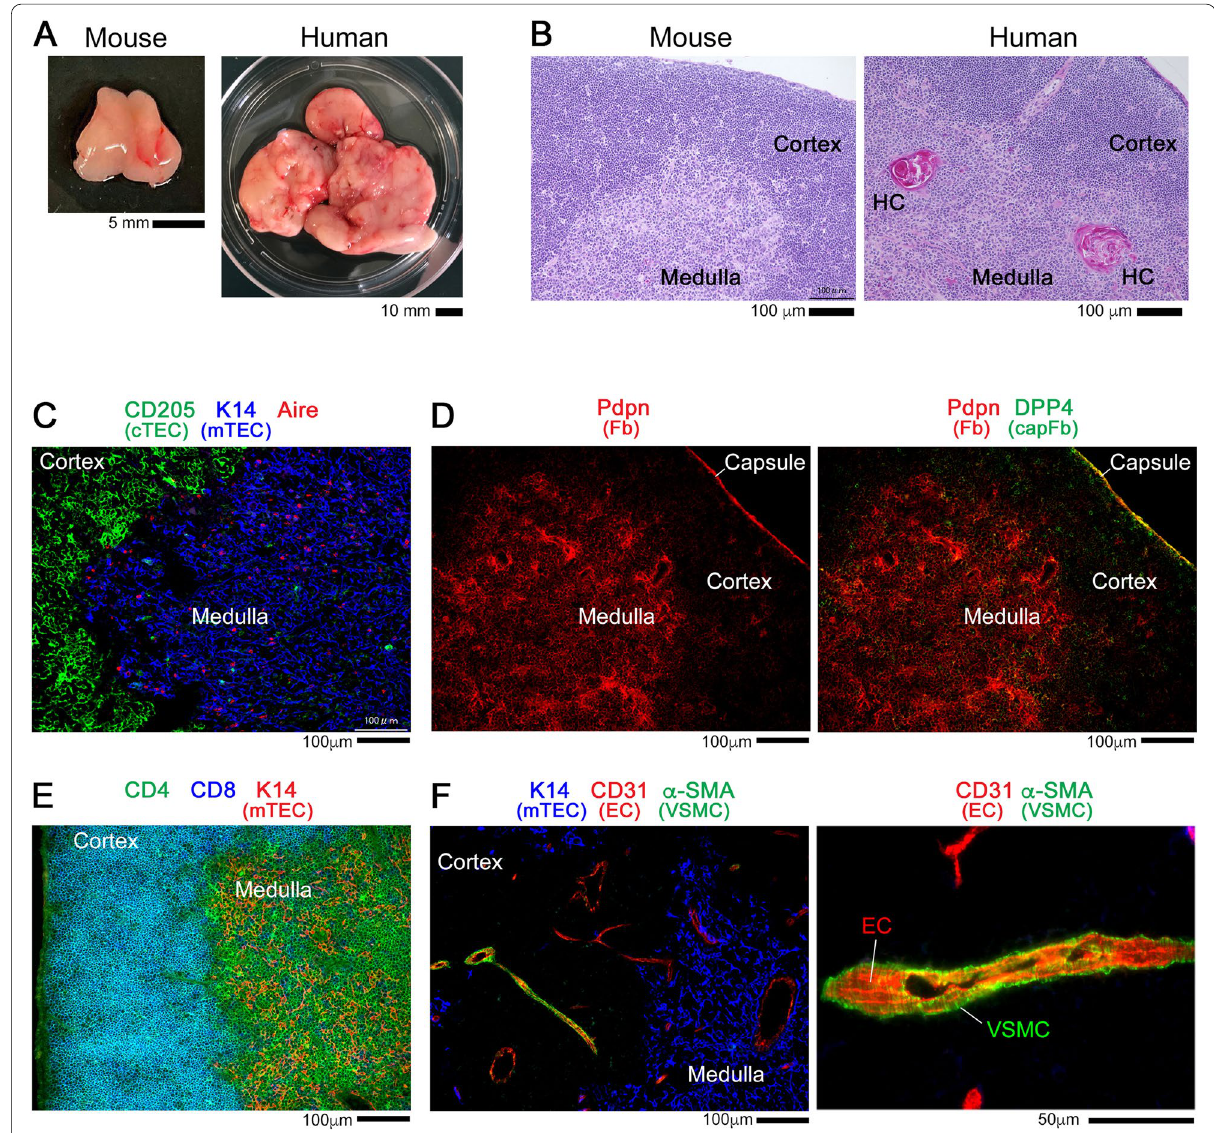
Fig. 1 Histological detection of thymic stromal cells. A Photographs of thymus from wild-type C57BL/6 mouse (5-week-old) or human (7-month-old). B Hematoxylin and eosin staining of thymus sections from C57BL/6 mouse (5-week-old) or human (7-month-old). In the human thymus, Hassall’s corpuscles (HCs), one of the final differentiation state of mTECs, are prominently detected within the medulla. C – F Thymus sections from 5-week-old C57BL/6 mice were stained for the indicated markers: CD205 (cTEC), keratin 14 (K14) (mTEC), Aire (mTEC), Pdpn (fibroblast, Fb), DPP4 (capFb), CD4, CD8, CD31 (endothelial cell, EC), and α-SMA